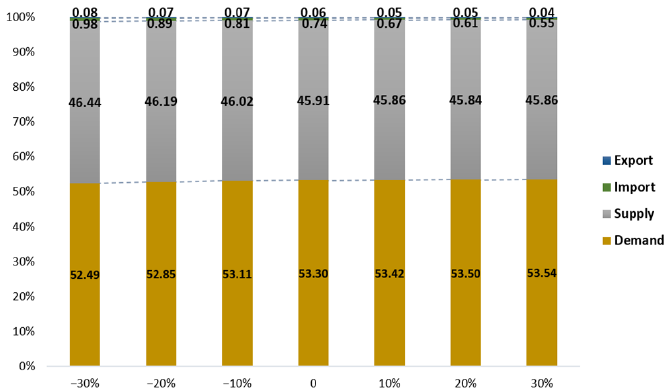
Figure 7. Numerical simulation results of onion.